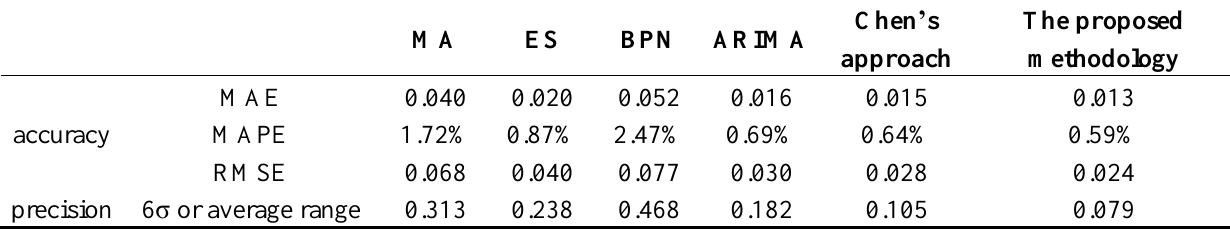
Table 1. The forecasting performances of different